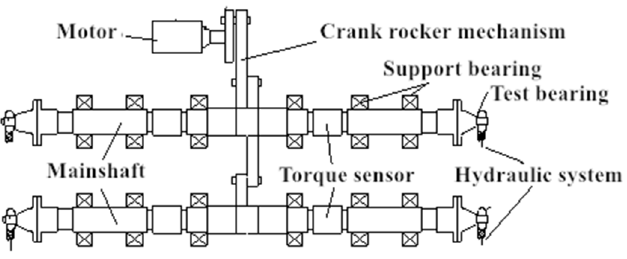
Fig. 3. Schematic diagram of the spherical plain bearing friction and wear tester.